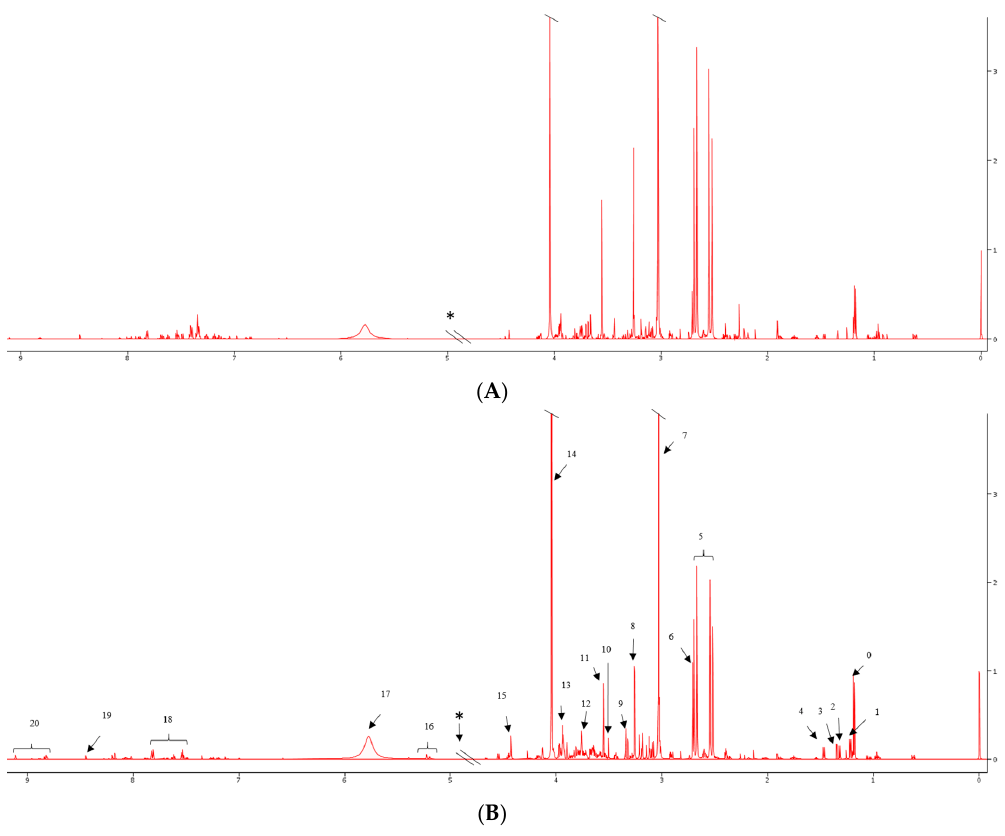
Figure 1. Characteristic NMR spectra of urine samples obtained from ( A ) benign (control); and ( B )